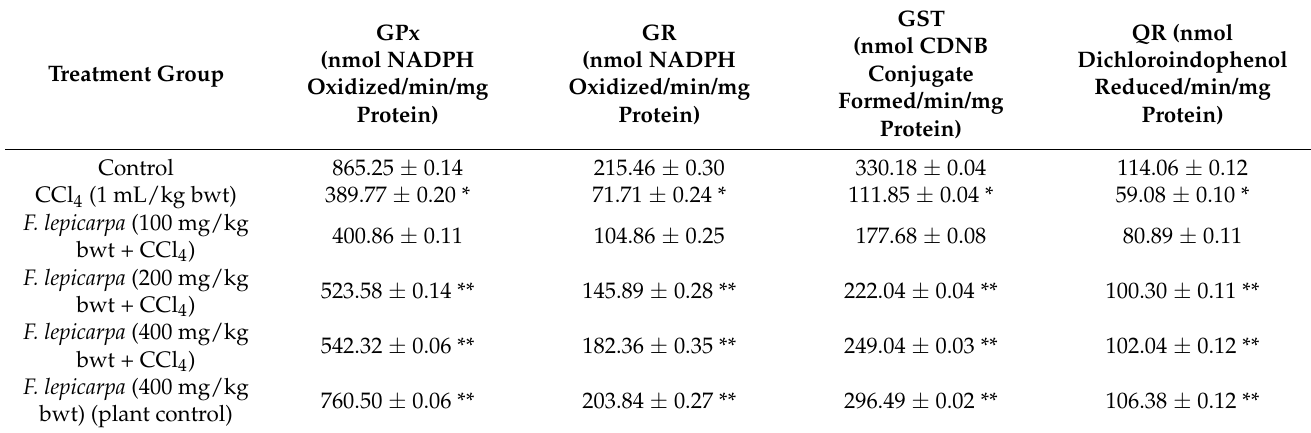
Table 6. Protective effects of F. lepicarpa on activities of hepatic antioxidant